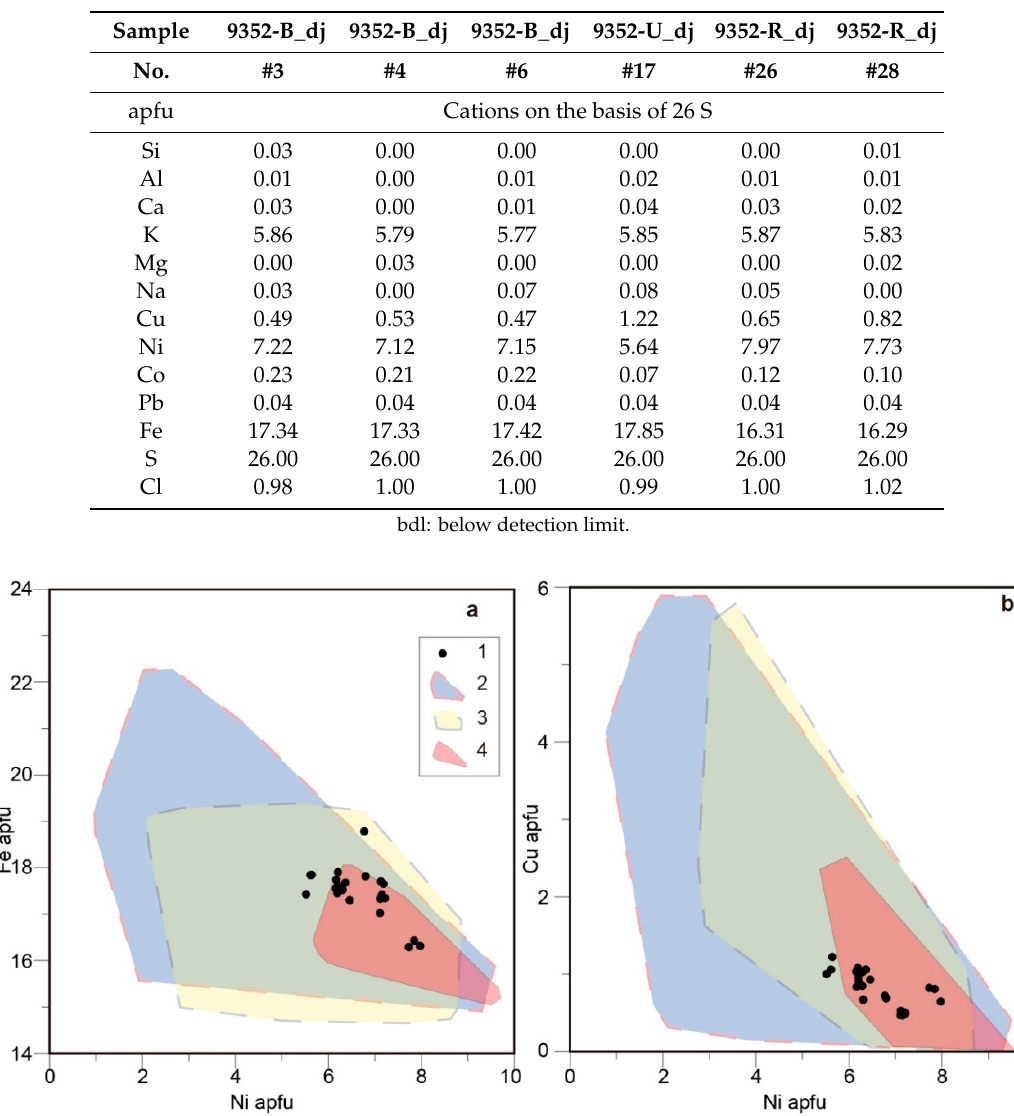
Figure 7. Diagrams showing the composition of djerfisherite. ( a ) Ni vs. Fe and ( b ) Ni vs. Cu plots; 1, djerfisherite from the groundmass of the site 73 Menominee kimberlite (this work); 2, djerfisherite from kimberlite groundmass and from melt inclusions in kimberlitic olivine from the Udachnaya-East pipe [28,29]; 3, djerfisherite from xenoliths from the Siberian kimberlites [29–34]; 4, djerfisherite from sulfide inclusions in the Siberian diamonds [30,35].